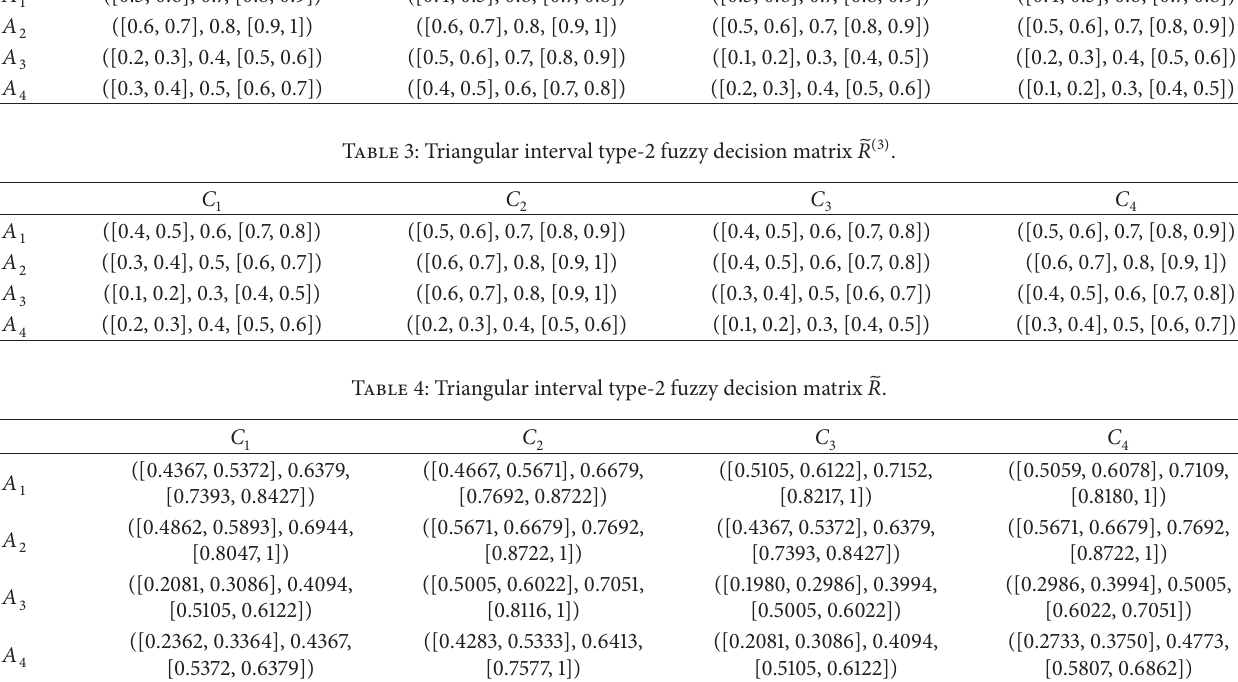
Table 2: Triangular interval type-2 fuzzy decision matrix